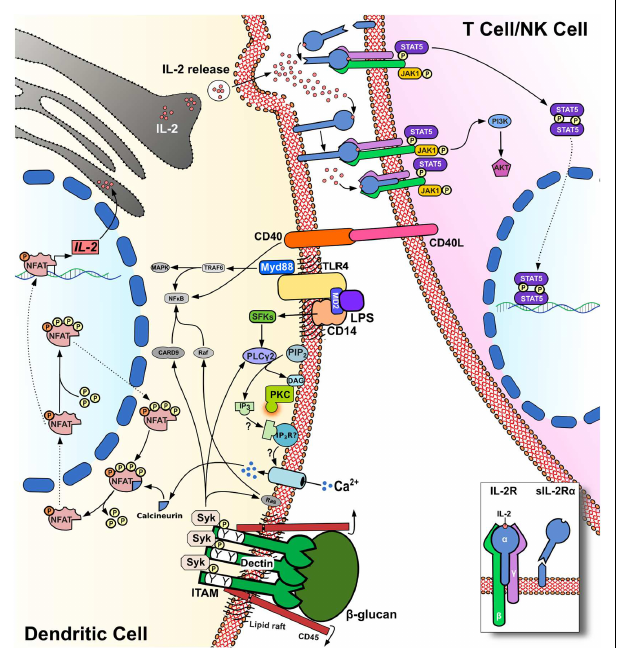
FIGURE 1 | IL-2 release by DCs stimulation of PRRs triggers the calcineurin/NFAT pathway via PLC- γ 2 and intracellular Ca 2 + flux . NFAT dephosphorylation by calcineurin leads to IL-2 transcription and release, which is increased in response to CD40/CD40L interactions. CD25 (IL-2R α ) can capture IL-2 release in the synaptic cleft on the surface of DCs for presentation in trans to